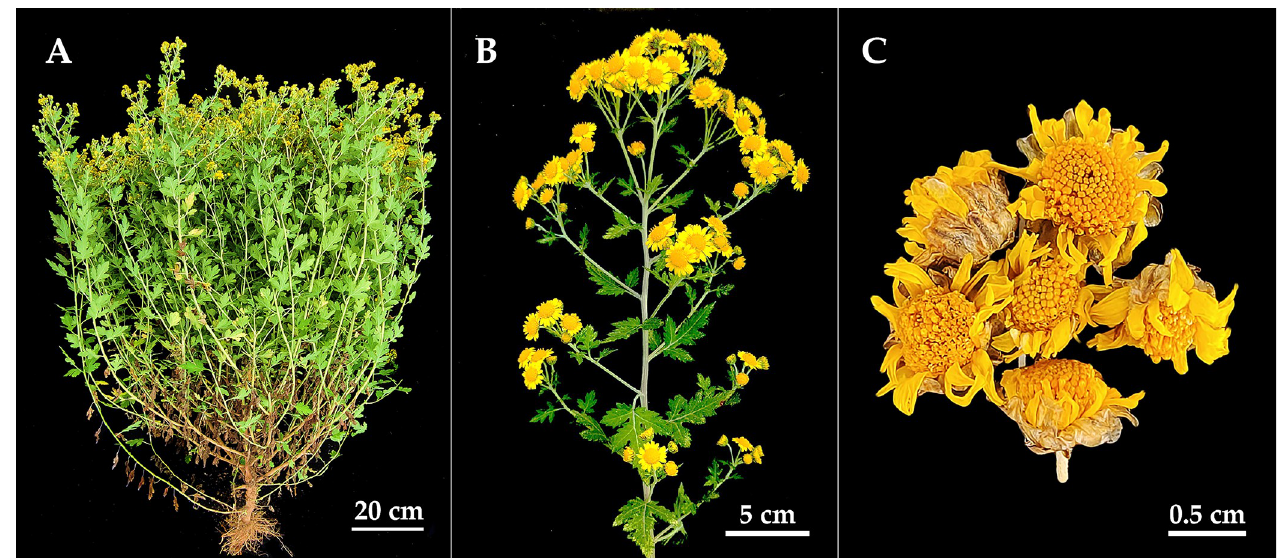
Fig 1. Morphological characteristics of C . indicum (A) plant, (B) panicles, and (C) dry inflorescence.